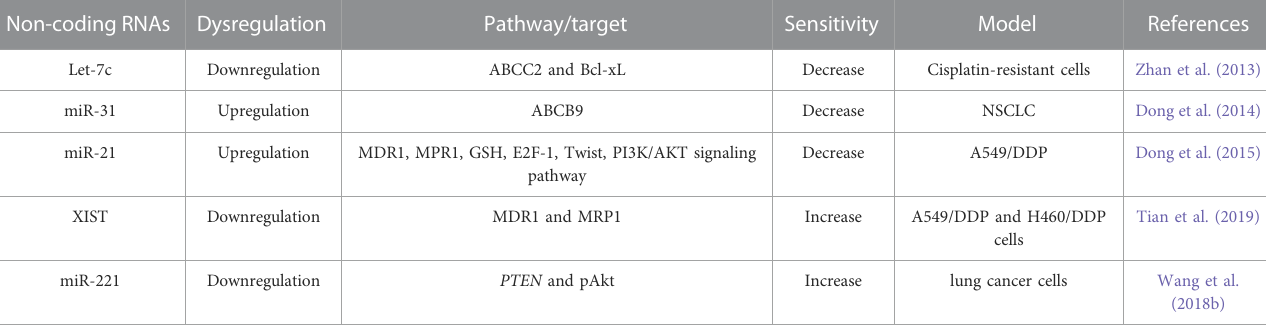
TABLE 1 Dysregulation of Non-coding RNAs on the drug transporters involved in cisplatin-resistance. Non-coding